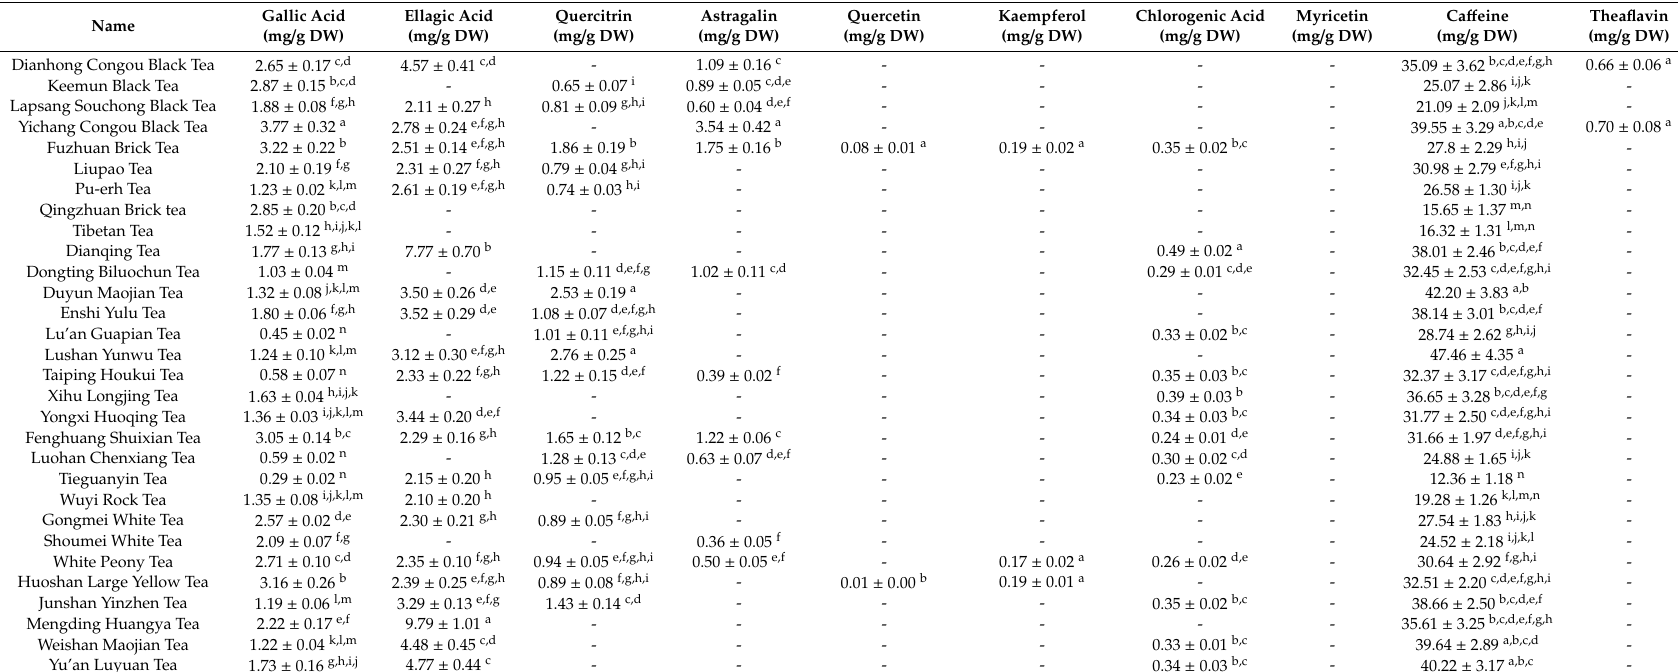
Di ff erent superscript lowercase letters within a column indicate statistical significance at p <